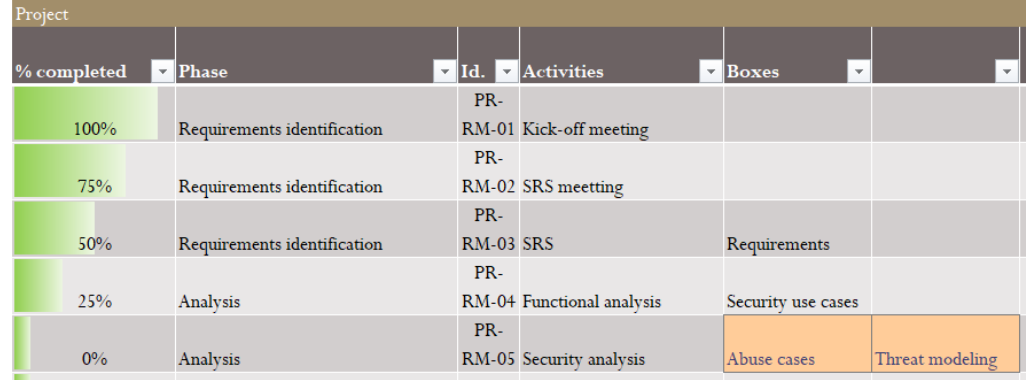
Figure 2. Backlog of activities.